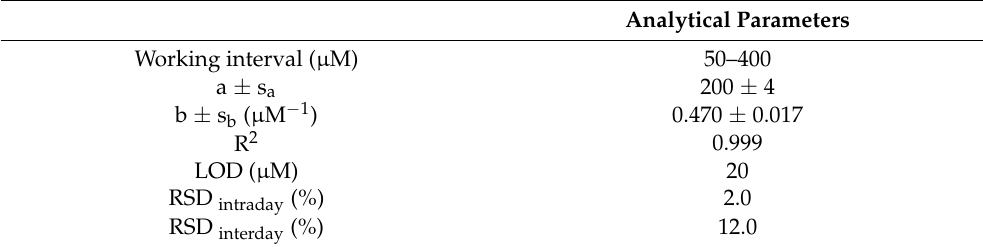
Table 1. Analytical parameters and precision (%RSD) values for the determination of CHLA by the CCD